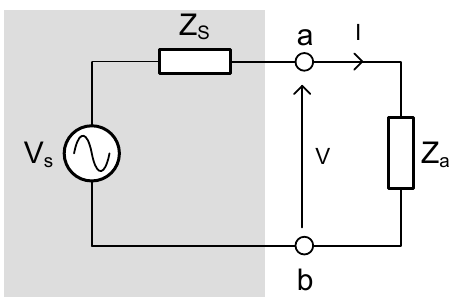
Figure 2. AC source with internal impedance loaded by impedance Z a .